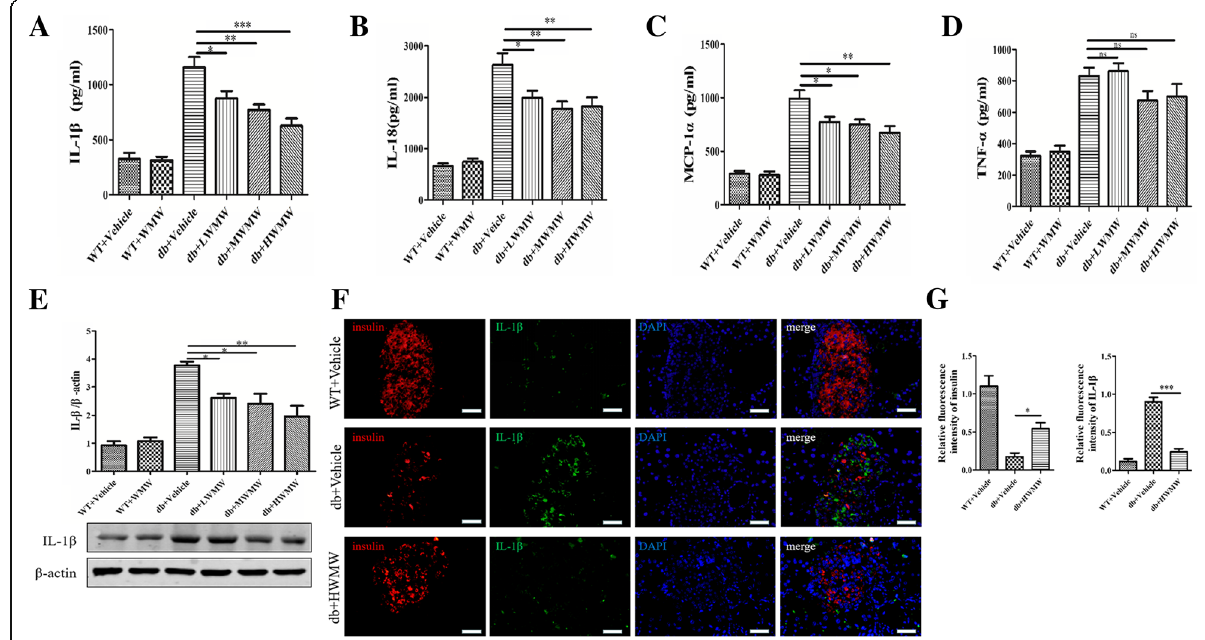
Fig. 5 Effect of WMW on the expression of IL-1 β and other proinflammatory cytokines in the mouse pancreas. Homogenates of mouse pancreas were tested by ELISA for ( a ) IL-1 β ; ( b ) IL-18; ( c ) MCP-1 α ; and ( d ) TNF- α . Western blot analysis for IL-1 β was performed ( e ). Band densities were converted to a bar graph. Immunofluorescence staining for insulin (red) and IL-1 β (green) in pancreatic islets from wild-type, db/db, and db/db mice treated with HWMW are illustrated in ( f ). Nuclei were counterstained with DAPI (blue). Signals for IL-1 β were calculated in bar graph ( g ). Scale: 25 μ m. P < 0.05 (*), P < 0.01 (**), P < 0.001 (***) ( n = 6)